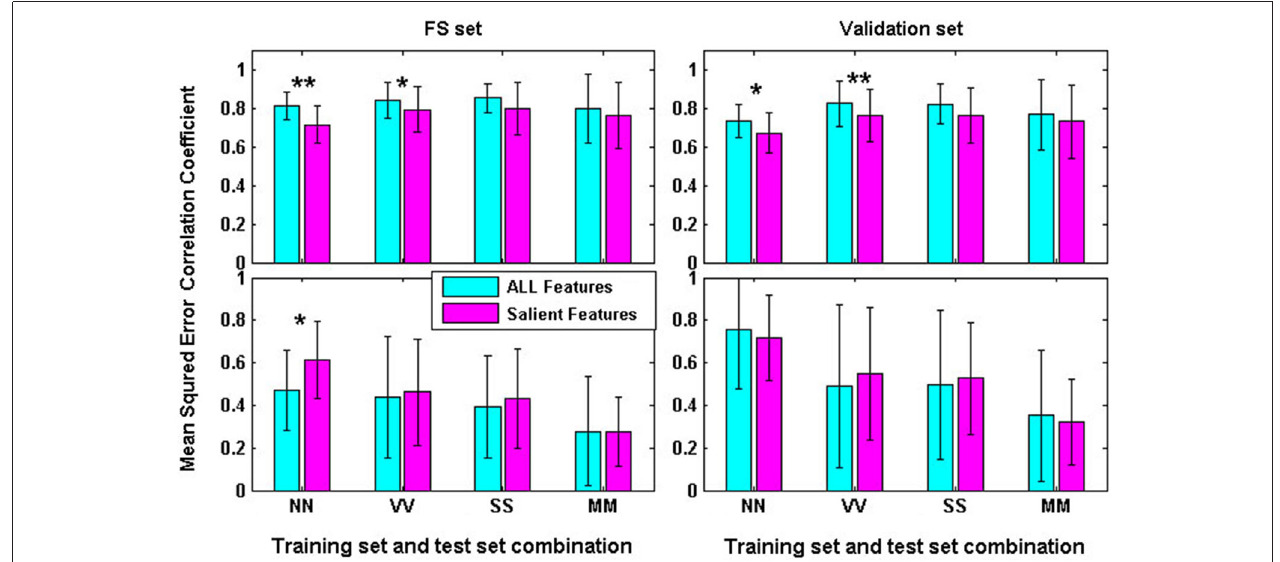
FIGURE 2 | Within-task regression performances for FS and Validation data with all features and the salient features picked out by RFE (* : p < 0.05; ** : p < 0.01)